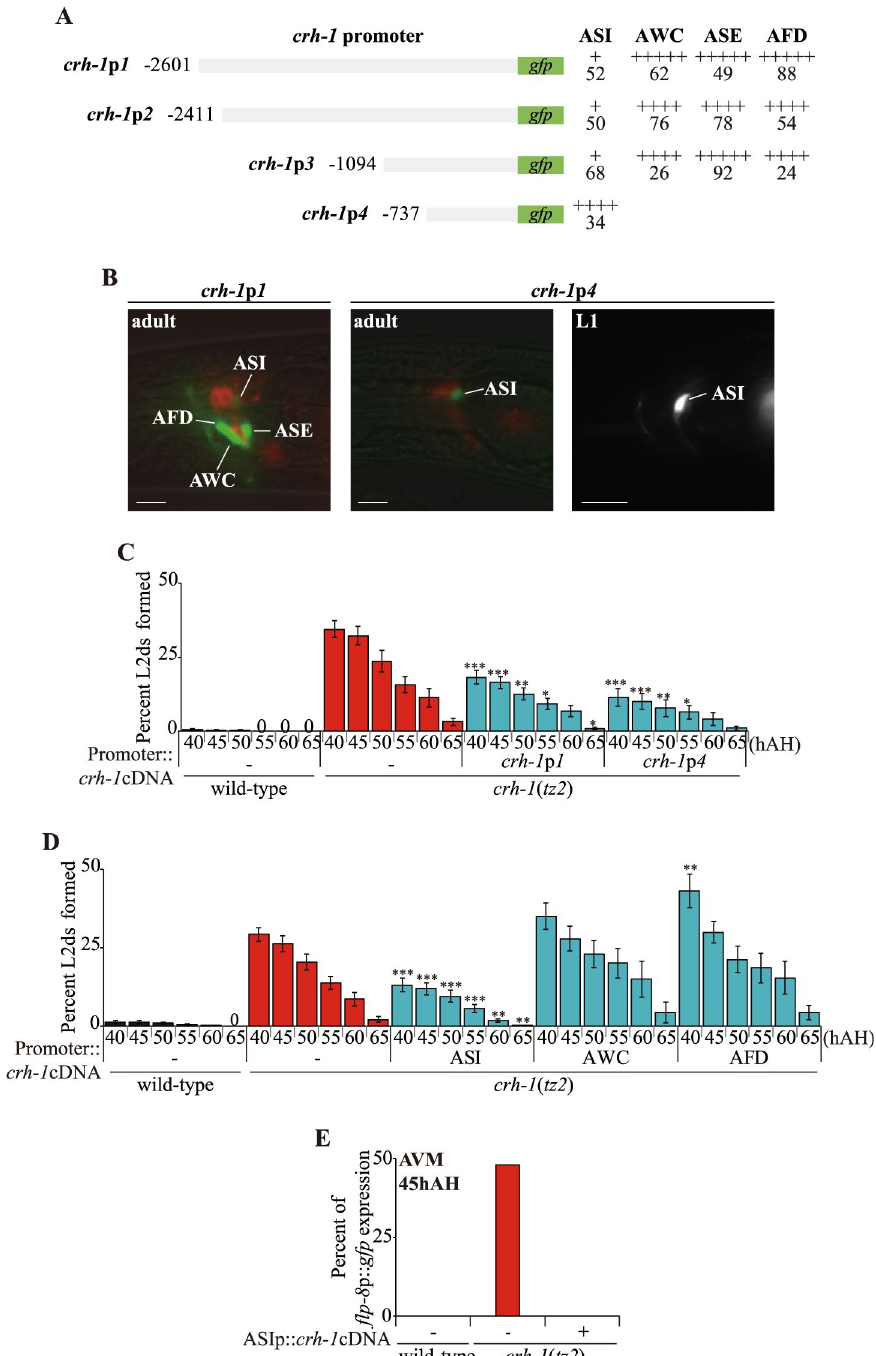
Fig 3. crh-1 is expressed and acts in the ASI neurons to regulate ascr#5-mediated L2d formation. (A) The percentage of adult transgenic animals expressing crh-1 p 1 :: gfp , crh-1 p 2 :: gfp , crh-1 p 3 :: gfp or crh-1 p 4 :: gfp reporter construct in the indicated neurons is shown. The strength of GFP expression is indicated by the number of + symbols. At least two independent extrachromosomal lines for each construct were examined. n � 60 for each. (B) Representative images of adult or L1 larval transgenic animals expressing gfp expression under the control of crh-1 promoter 1 ( crh-1 p 1 ) and crh-1 promoter 4 ( crh-1 p 4 ). Adult animals were dye-filled with DiI. Scale bar: 10 μ m. (C and D) Percent of L2d formed by animals of the indicated genotypes when grown in the presence of live OP50 food and ascr#5 pheromone. N � 6 for each. Error bars indicate SEM. � , �� , and ��� indicate different from crh-1 mutants